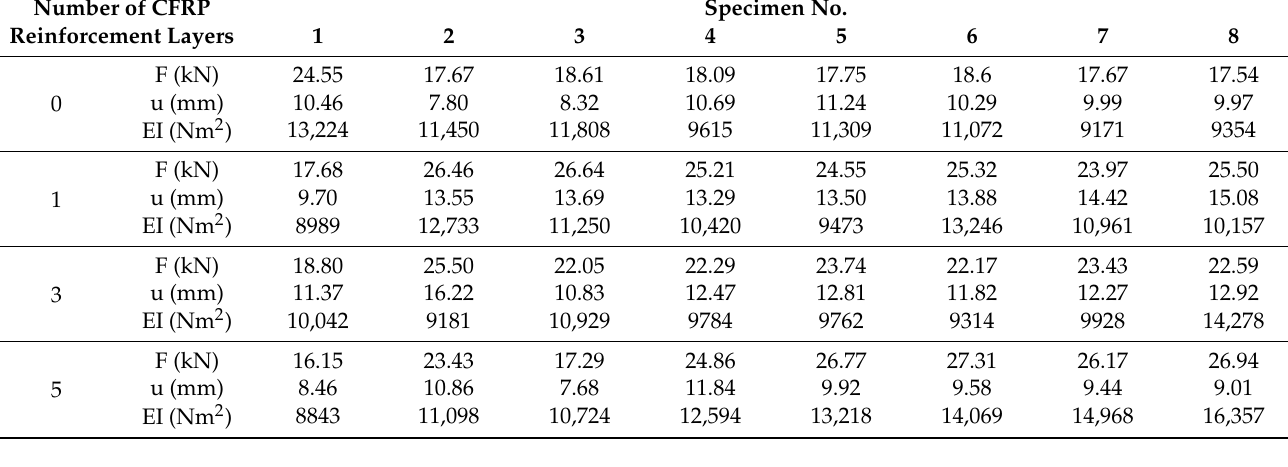
Table 2. Detailed results for the reference beams and the beams reinforced with CFRP.